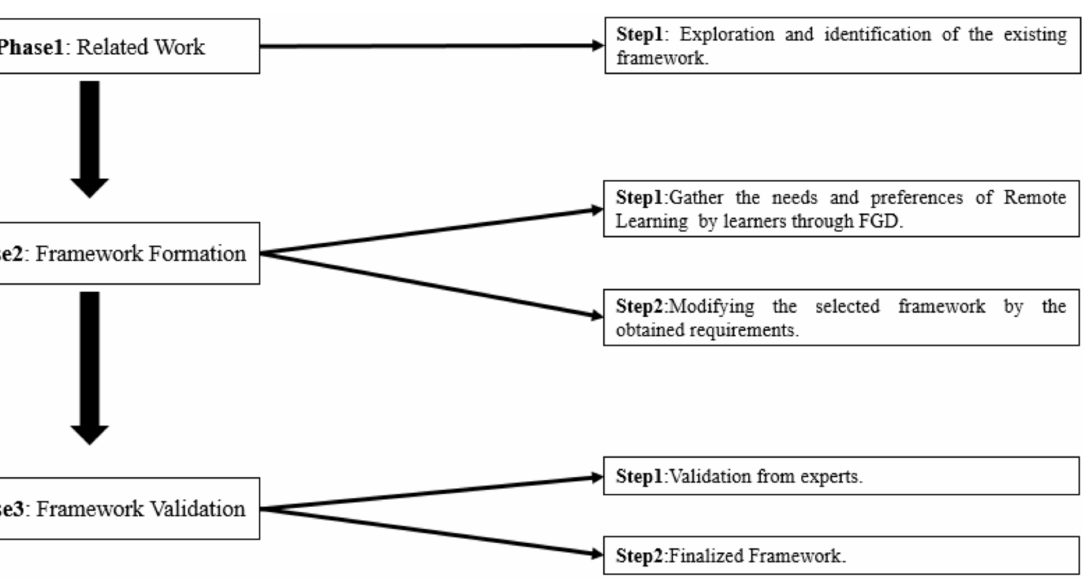
Figure 1. Workflow diagram of this